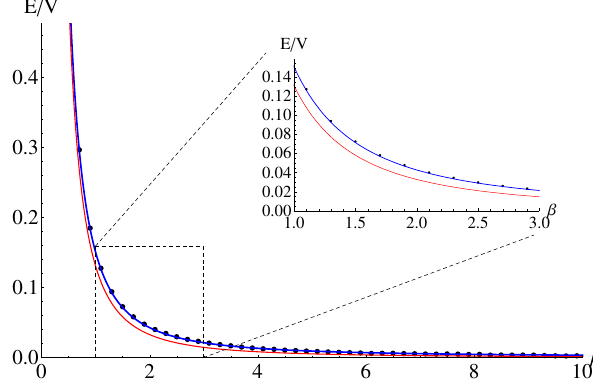
Figure 14 . Blue (upper): exact occupation number h N ! i from (C.10) with (cid:12) = 2. Red (lower): semi-classical fermionic (Fermi-Dirac) spectrum of Unruh radiation, coming from (C.12).